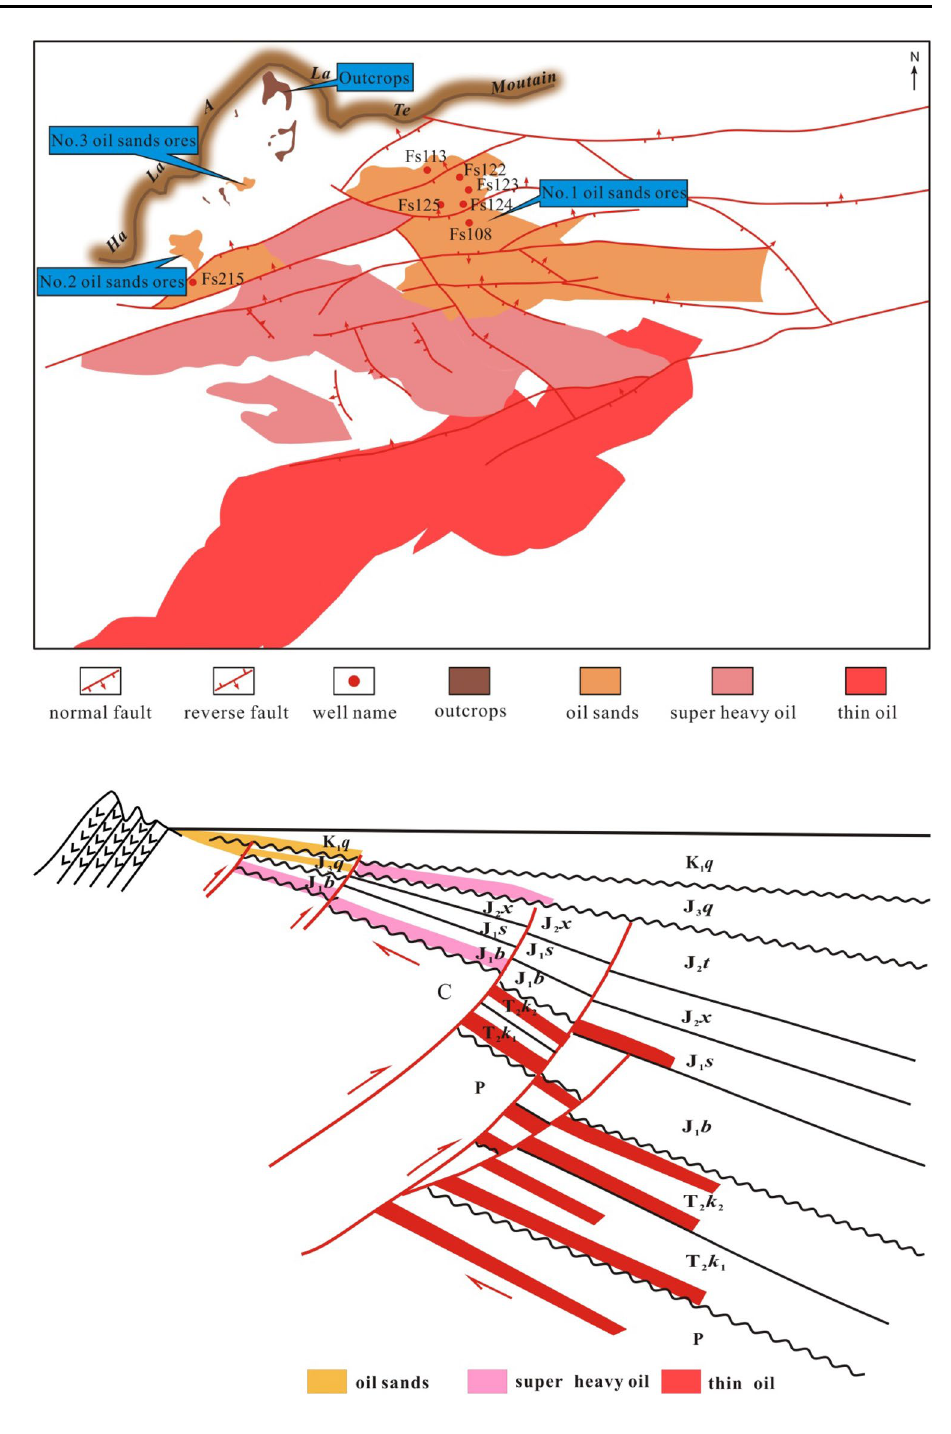
Fig. 1 Exploration results of oil sands, heavy oil and thin oil reservoirs in Fengcheng area